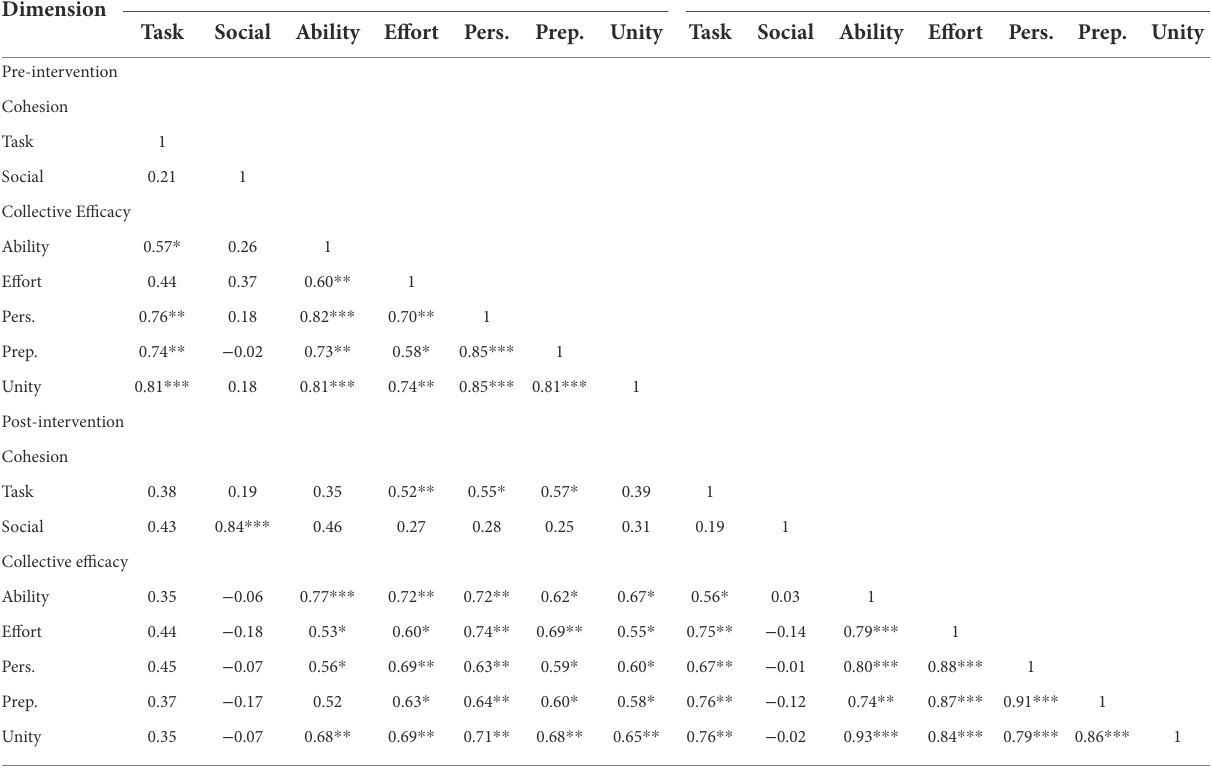
TABLE 1 Intercorrlations between task cohesion, social cohesion, and collective efficacy.